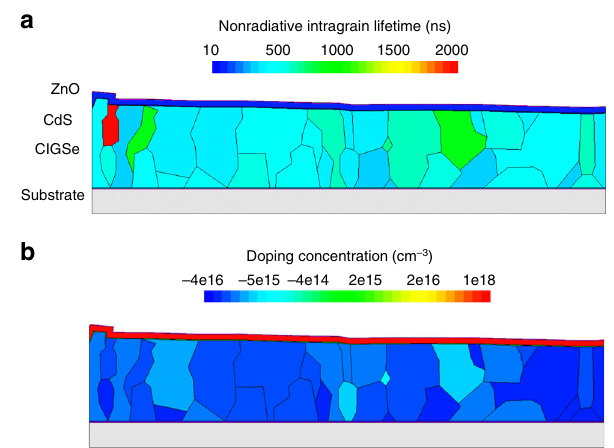
Fig. 7 Device models including laterally varying lifetime and net-doping densities. a Distribution of electron lifetime and b doping concentration corresponding to the cross-sectional microstructure obtained by EBSD (Supplementary Fig. 3). Simulation is based on Gaussian distributed experimental values. Note that negative doping concentrations denote those of acceptors, whereas positive values are those of donors. Table 3 Simulated photovoltaic parameters of cells with various inhomogeneities.